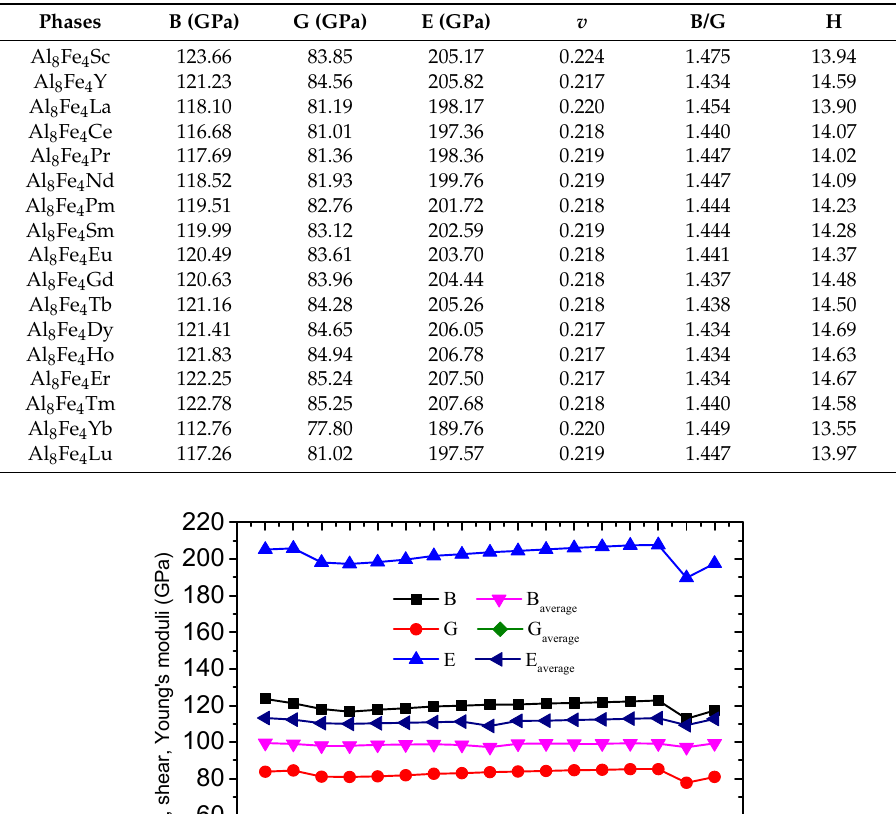
Table 3. The calculated bulk modulus B, shear modulus G, Young’s modulus E, Poisson’s ratio v , B/G ratio, and hardness H of Al 8 Fe 4 RE IMCs.